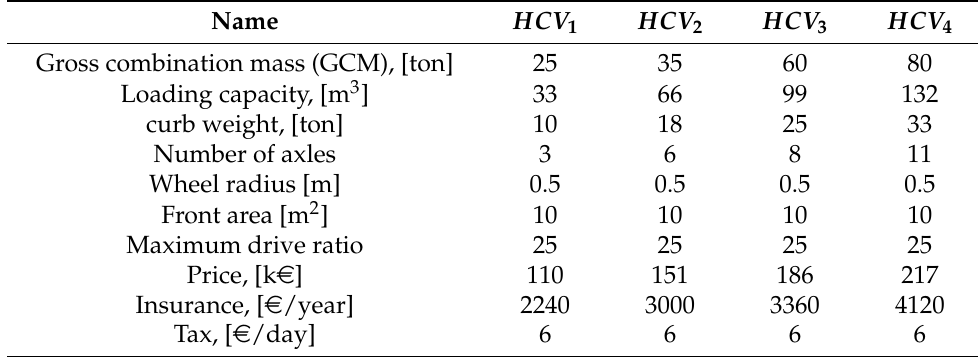
Table A3. Chassis data of heavy combination vehicles (HCV).